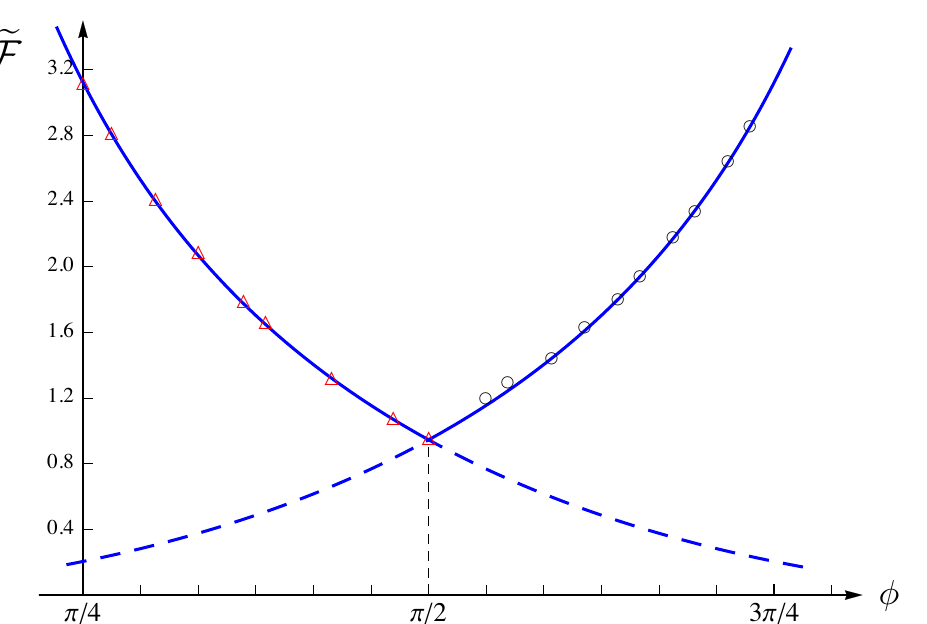
Figure 6 . Corner function for a vertex with four edges in AdS 4 /CFT 3 in the symmetric case where (cid:30) 1 = (cid:30) 2 (cid:17) (cid:30) and ’ 1 = ’ 2 = (cid:25) (cid:0) (cid:30) (see section 3.2). The points labeled by the red triangles come from surfaces like the one in the top panel of (cid:12)gure 5, while the points labeled by the black empty circles are obtained from surfaces like the one in the bottom panel of (cid:12)gure 5. The solid curve corresponds to the analytic expression